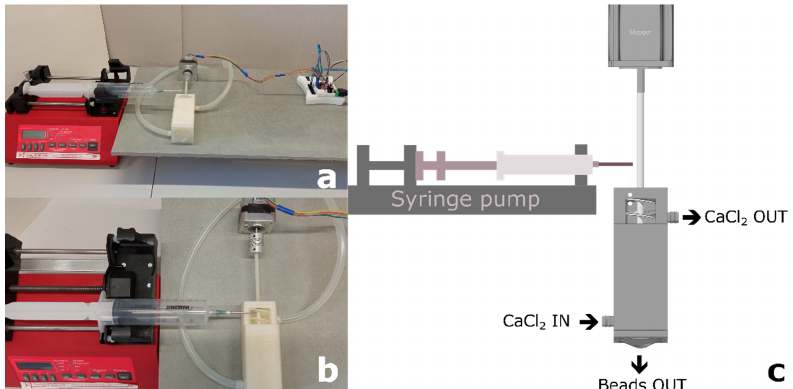
Figure 2. Photo of the prototype ( a , b ) and schematic diagram ( c ) of experimental stand.